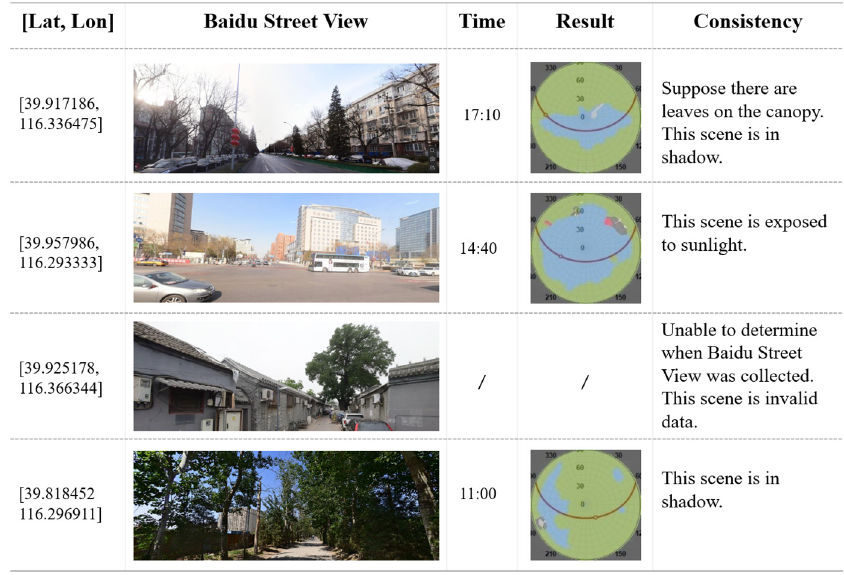
Figure 6. Comparison of our predicted results with the BSV data.